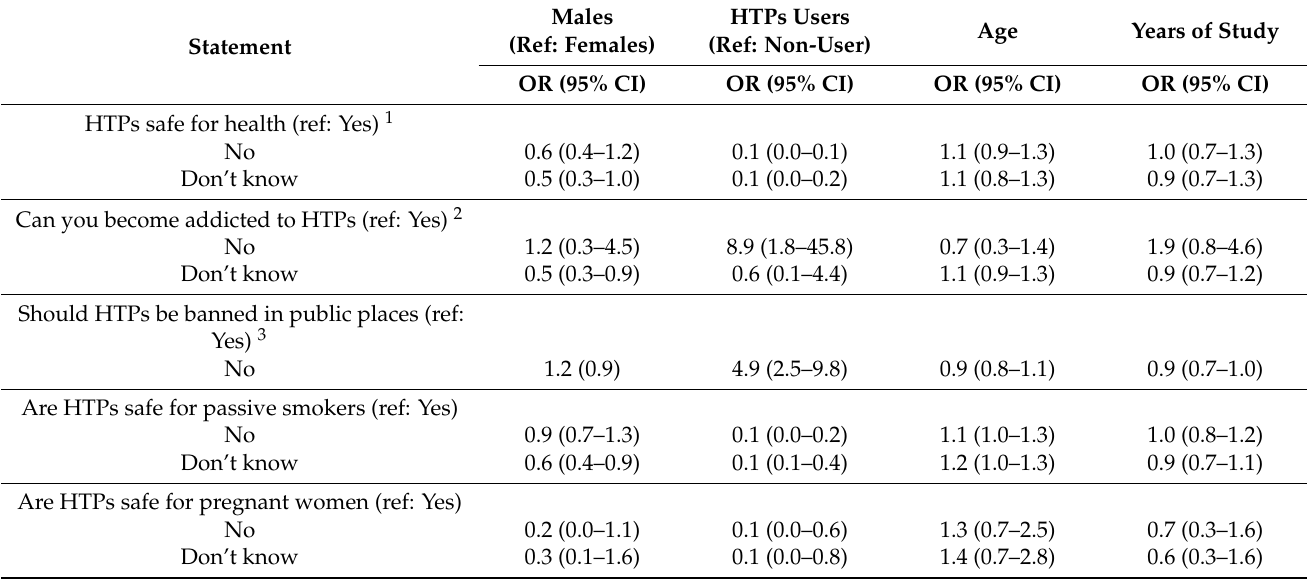
Table 5. Results (odds ratio) from the adjusted analysis looking at beliefs around health impacts among those who have heard of HTPs ( n =